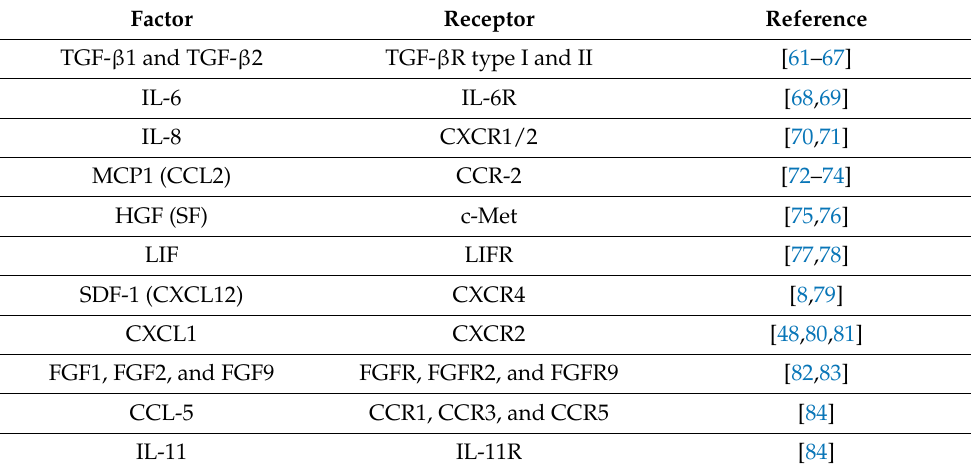
Table 1. Signaling molecules and growth factors secreted by CAFs into the TME.